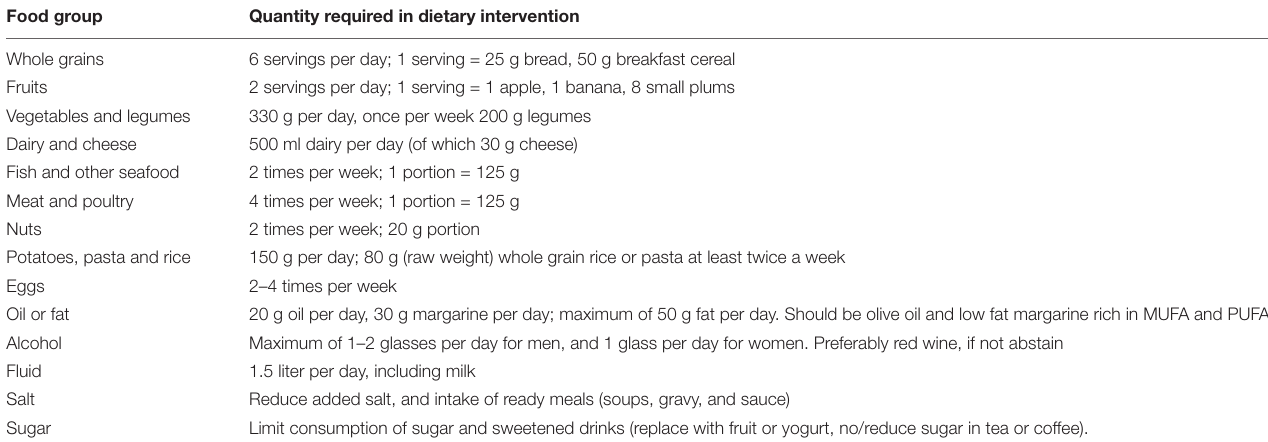
TABLE 1 | Quantitative dietary guidelines given to study